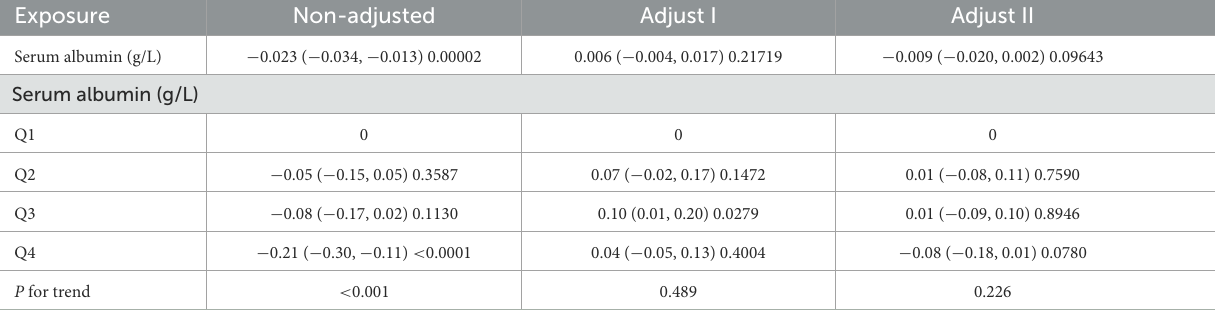
TABLE 2 Univariate and multivariate analysis by weighted linear regression model. Exposure Non-adjusted Adjust I Adjust